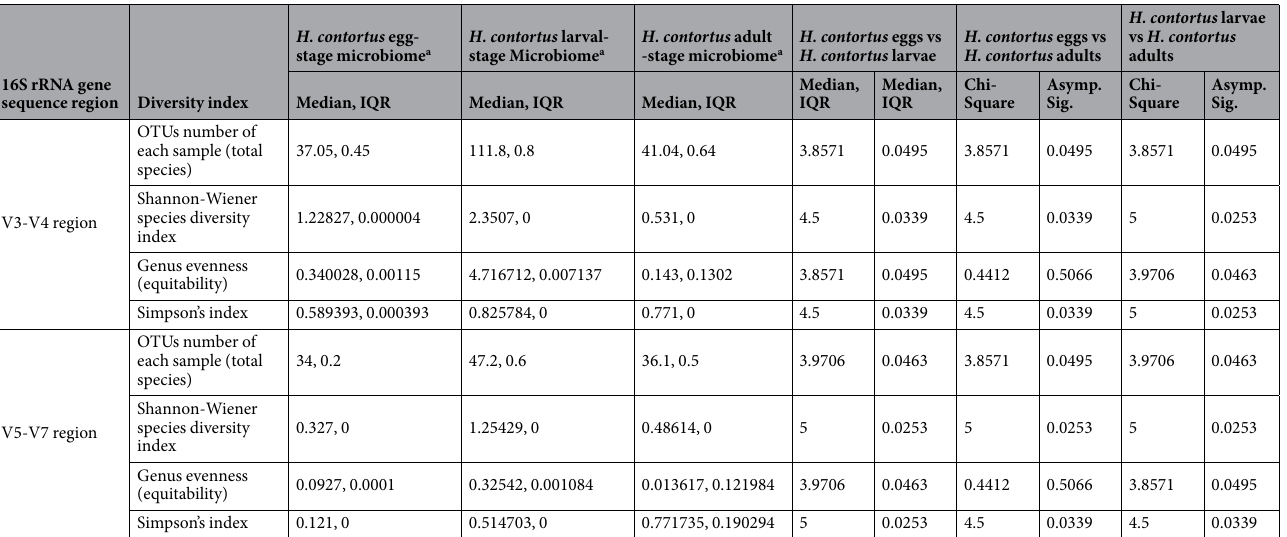
Table 2. Overview of alpha diversity metrics (interquartile range (IQR) and median) for the different life-cycle stage microbiome. P -values were calculated using Kruskal-Wallis test. The level of significance was determined at P < 0.05. a Data represent median and interquartile range (IQR) values from pooled populations (i.e. from each sheep) of eggs/larvae/adults (male and female) come from three different sheep (natural